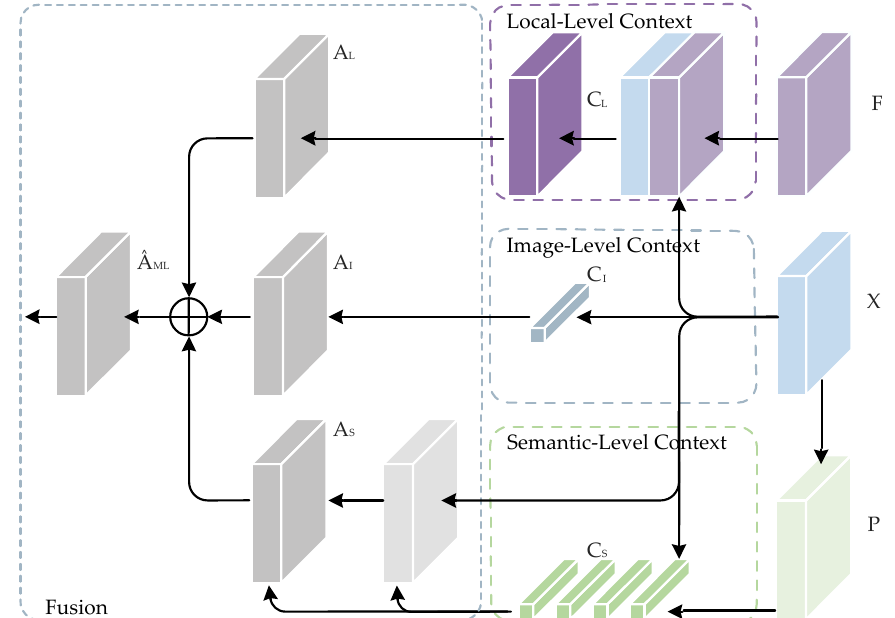
Figure 3. The multi-level context transform (MCT) module.